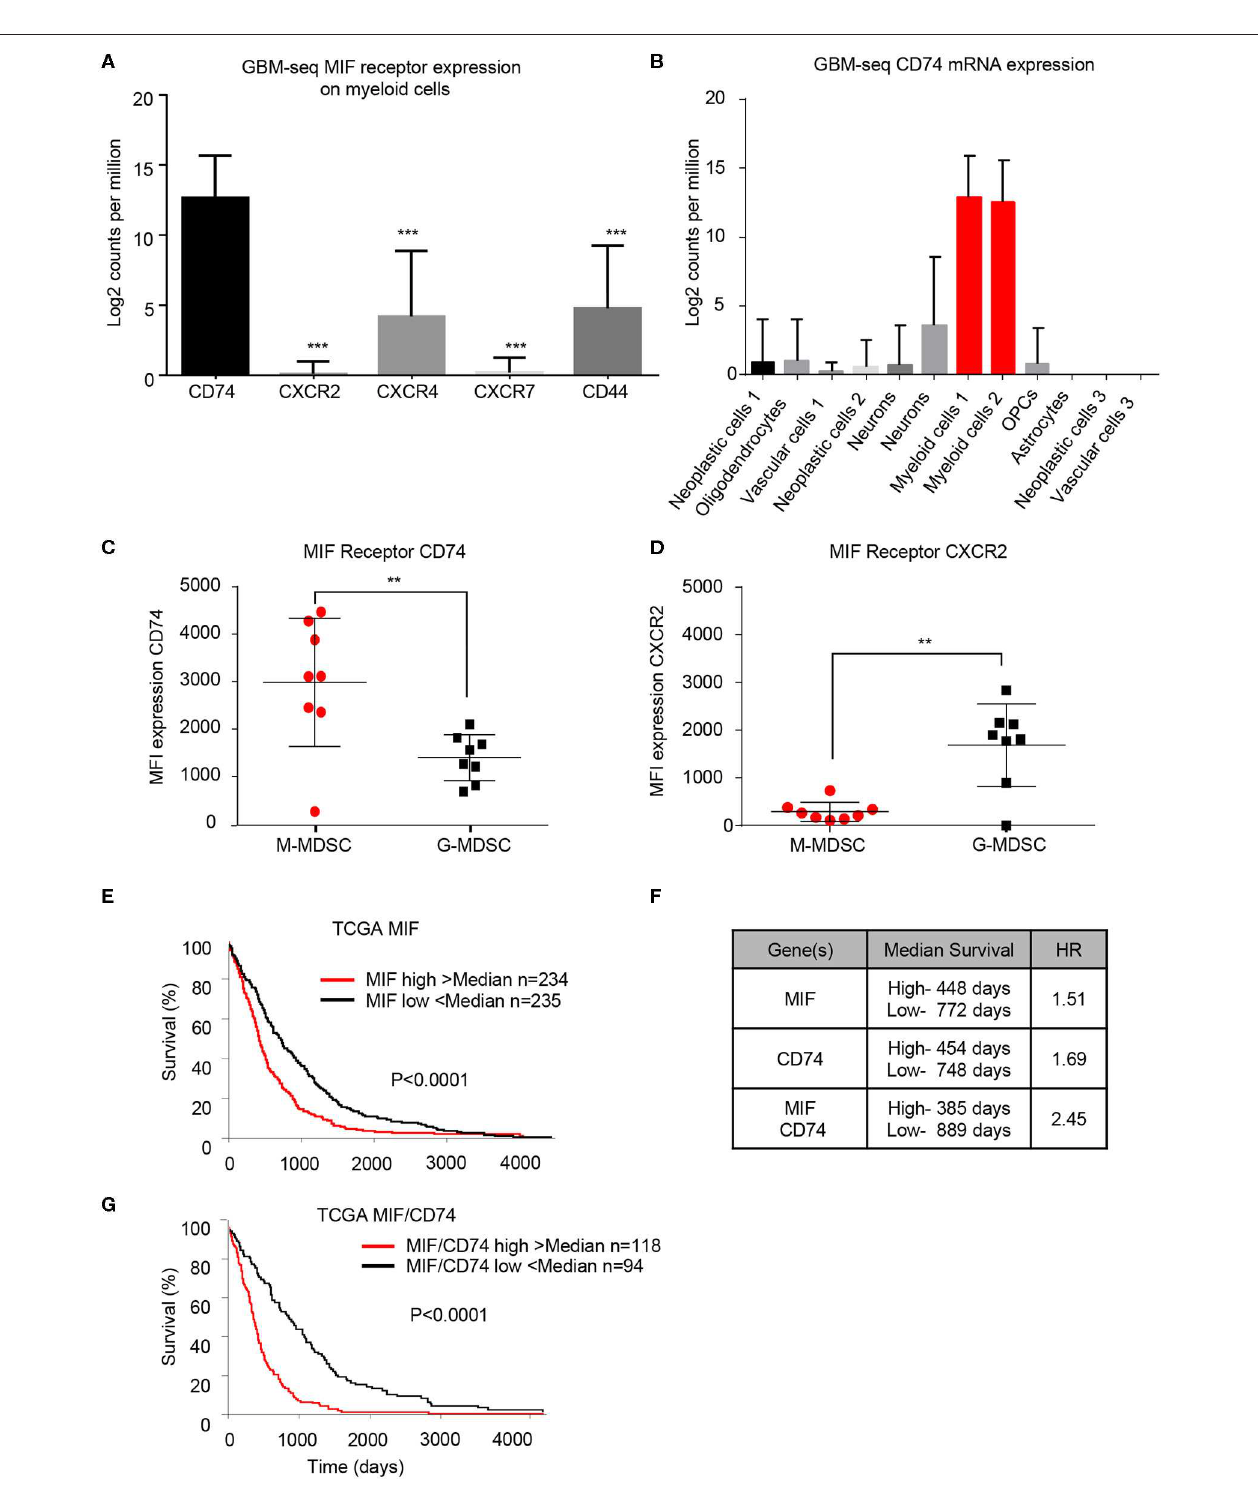
FIGURE 3 | Human derived M-MDSCs express the MIF receptor CD74. Data mining of the GBM-seq database from Darmanis et al. (51), was used to analyze the myeloid cell expression of the MIF receptors CD74, CXCR2, CXCR4, CXCR7 and CD44 showing that CD74 expressed by the myeloid populations in GBM tumor